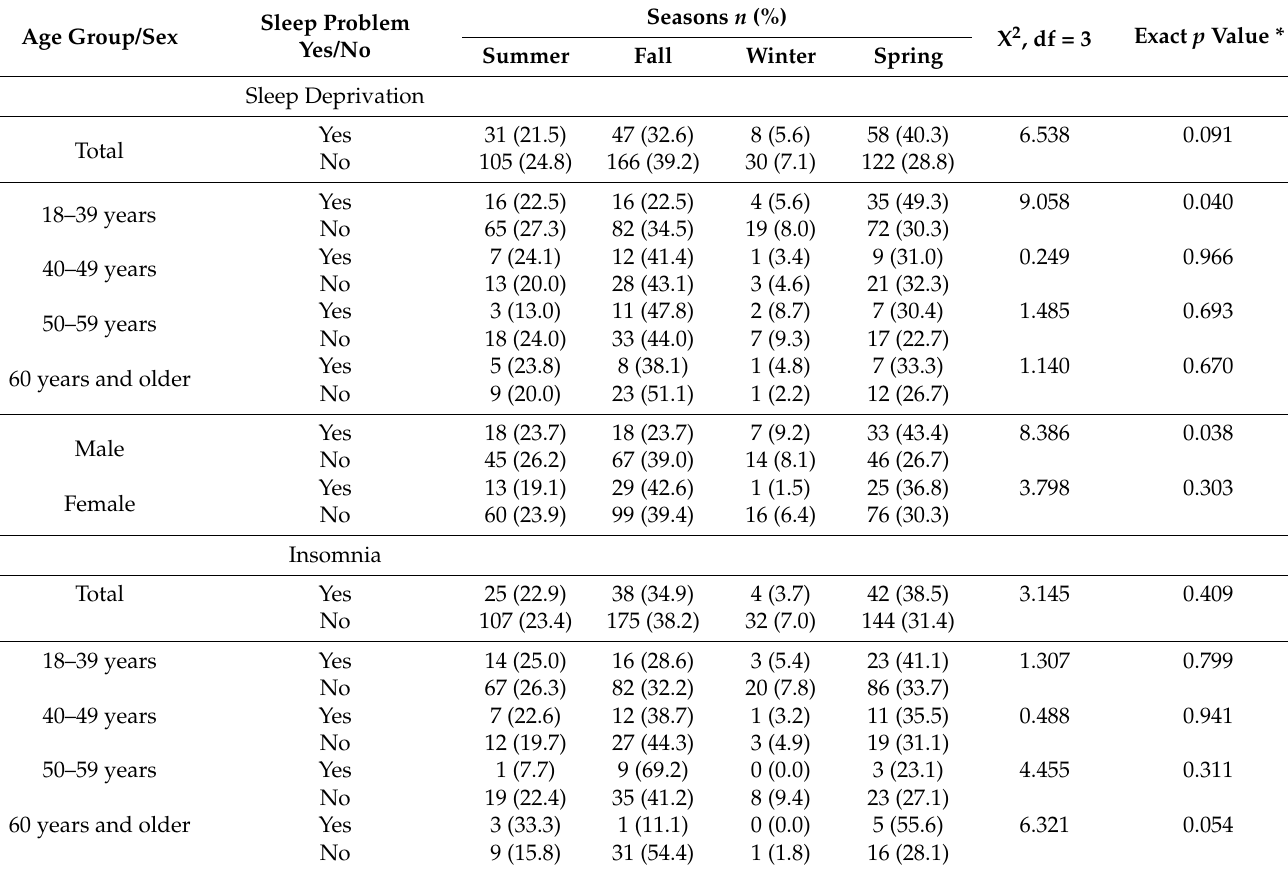
Table 3. Sleep problems by seasons based on astronomical start dates by age group and